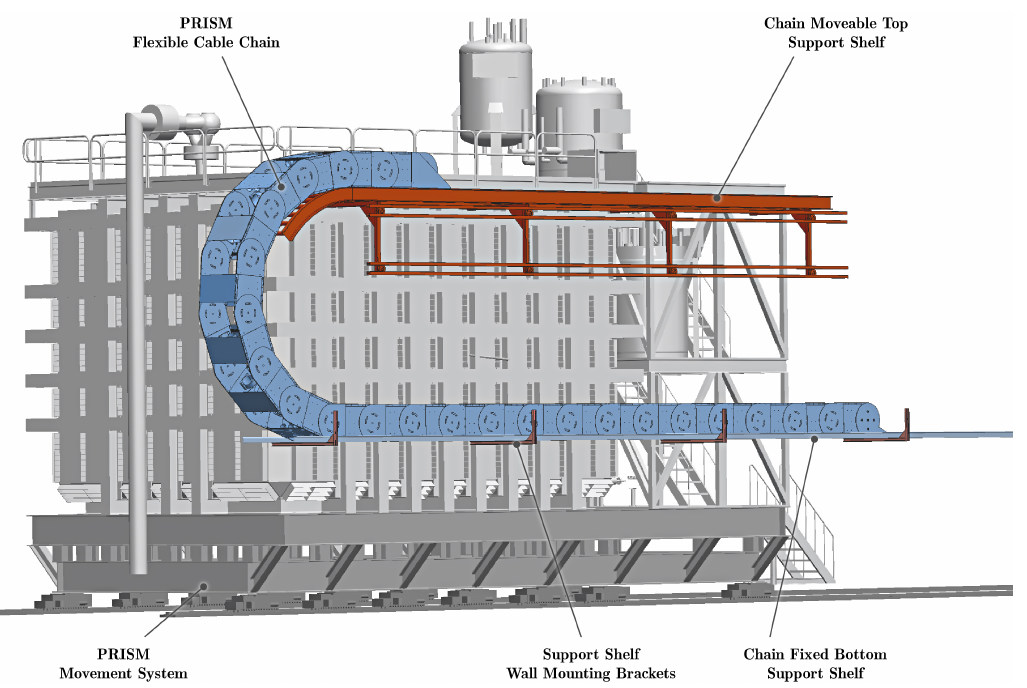
Figure 178. Heavy-duty cable chains are being developed for both movable DUNE ND subdetectors. The chains carry several flexible cryogenic lines of significant outside diameter, plus electrical power and data